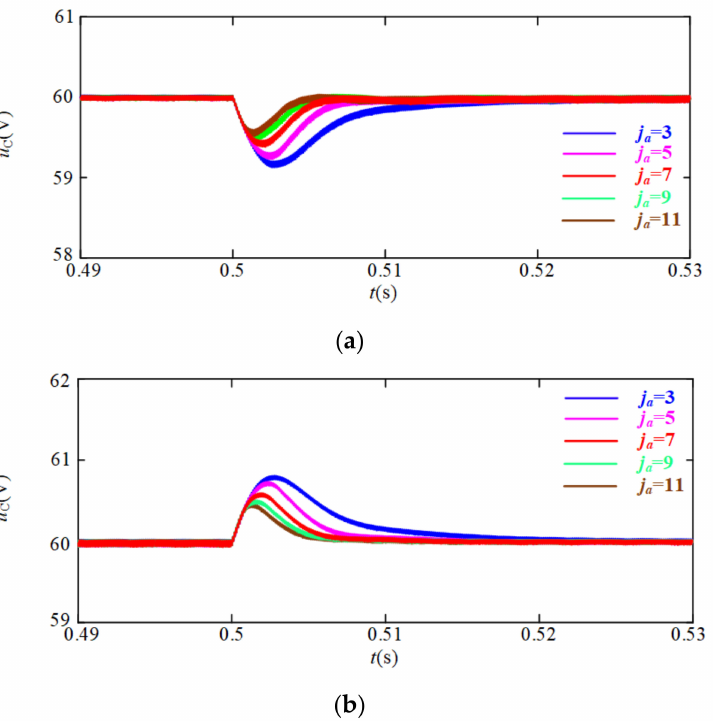
Figure 10. Simulated u C responses of the different j a when CPL steps up and down. ( a ) CPL: 60 W to 90 W; ( b ) CPL: 90 W to 60